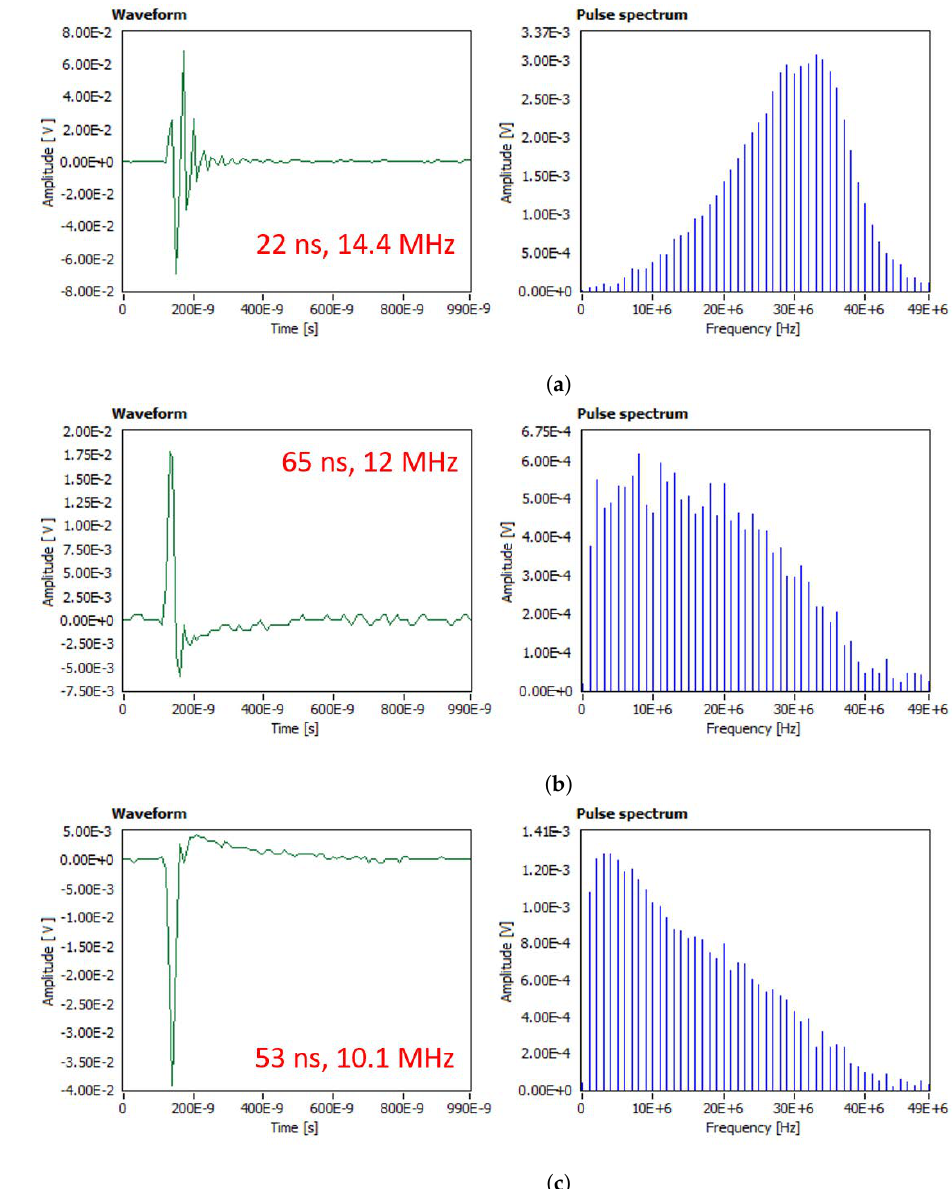
Figure 7. Mobile discharge pulse waveforms and corresponding frequency spectra. T 2 , W 2 co- ordinates of each pulse are shown on the time domain graphs. ( a ) AC pulse appears oscillatory. ( b ) Negative DC pulse. ( c ) Positive DC